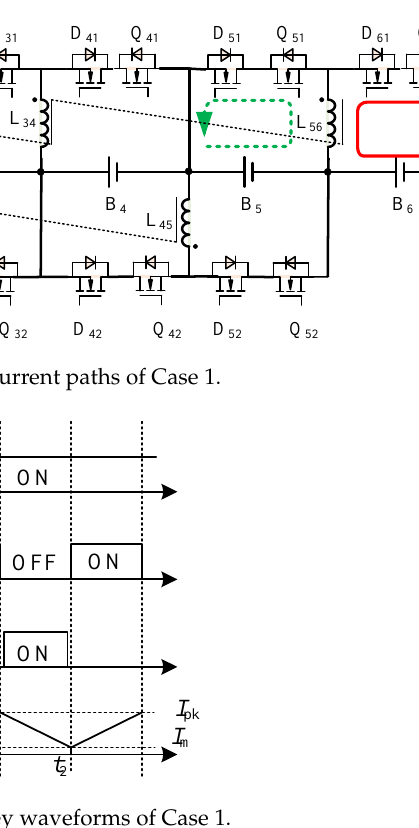
Figure 7. The key waveforms of Case 1.